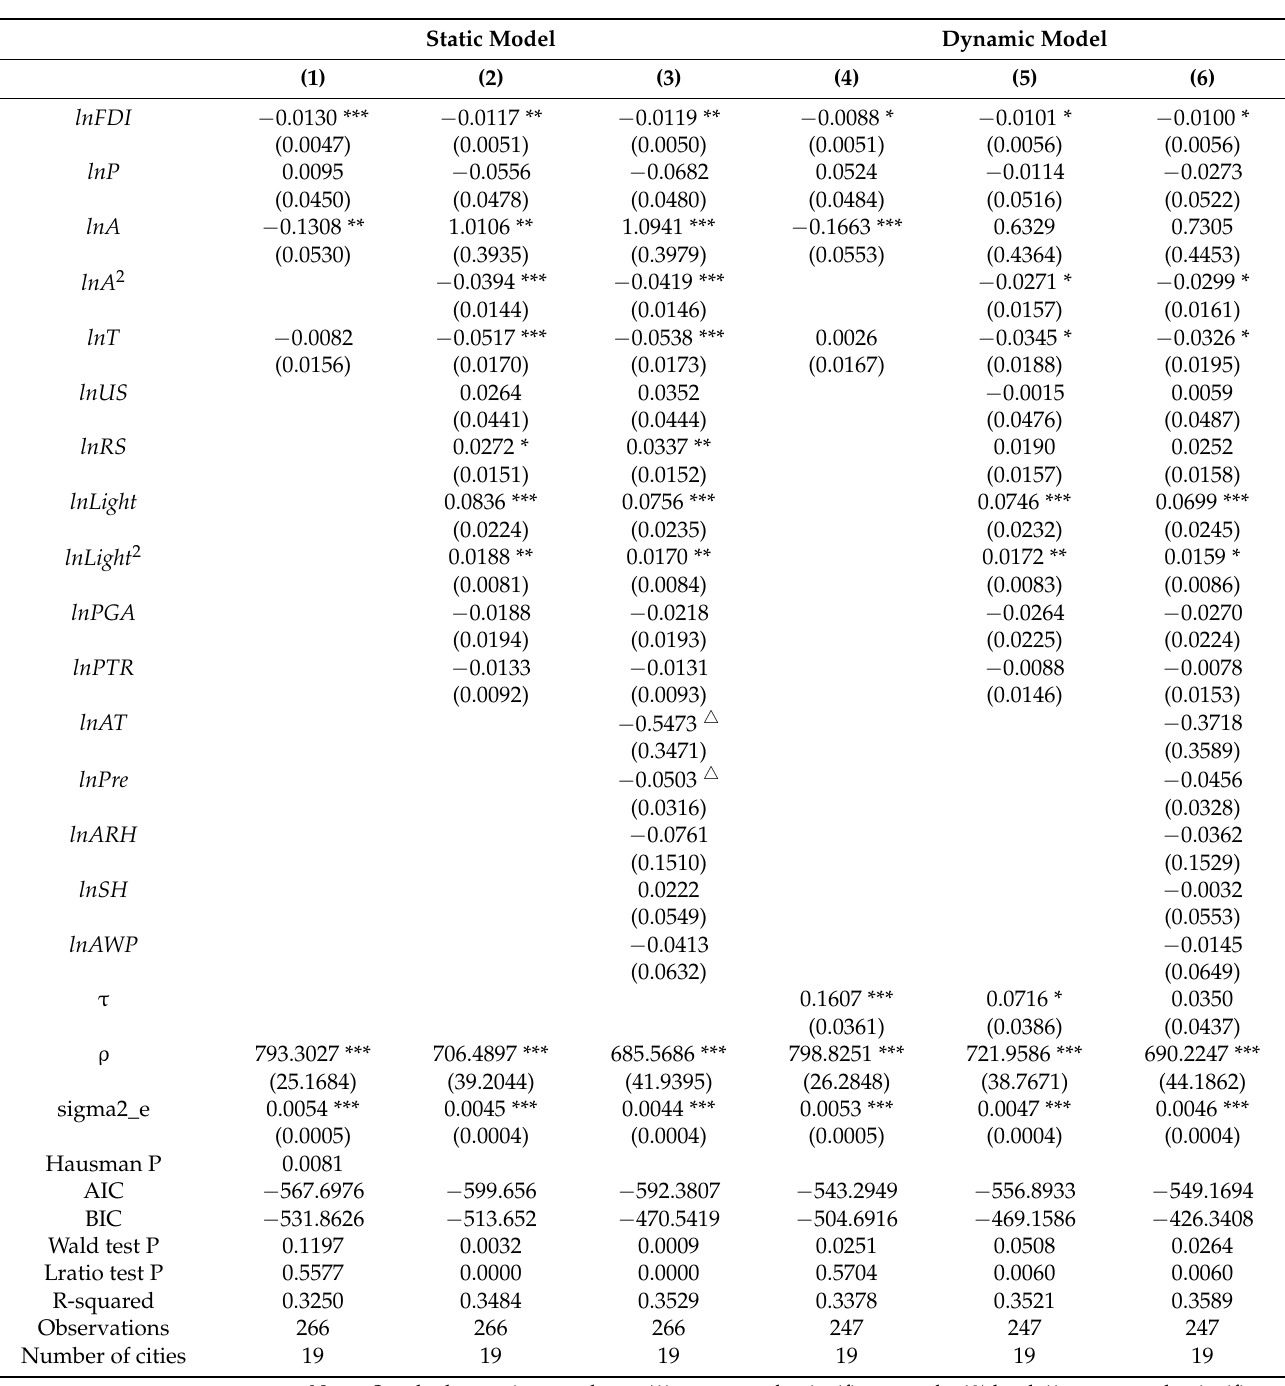
Table 4. Regression results for the